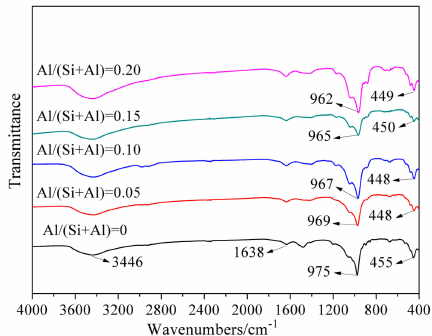
Figure 5. FT–IR spectra of Al-substituted tobermorite with di ff erent Al / (Si + Al) molar ratios.